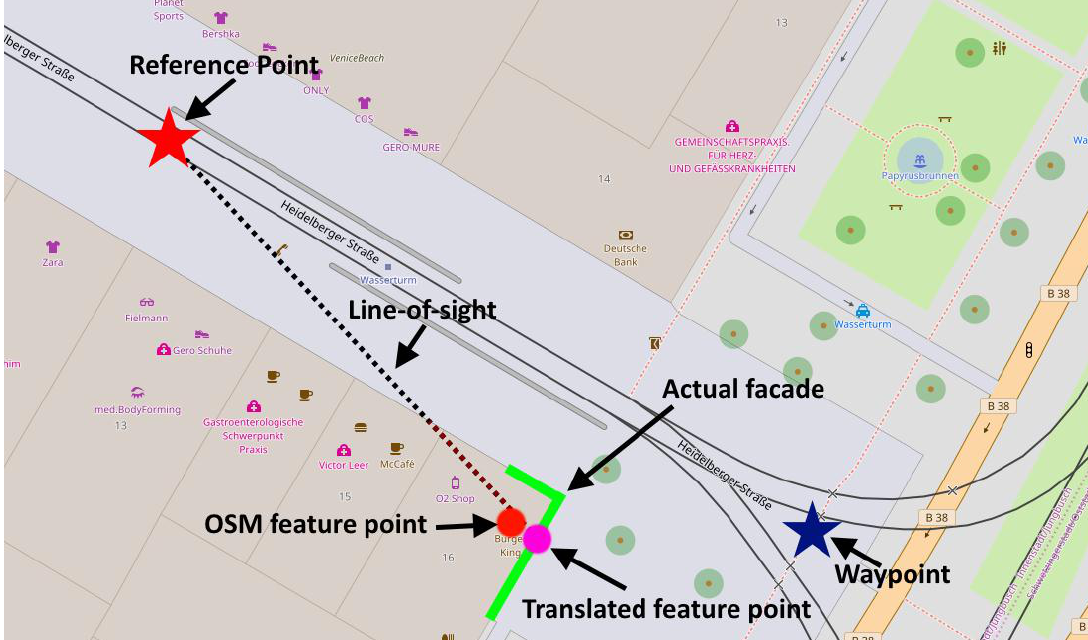
Figure 8. A falsely rejected landmark (base map © OpenStreetMap contributors).